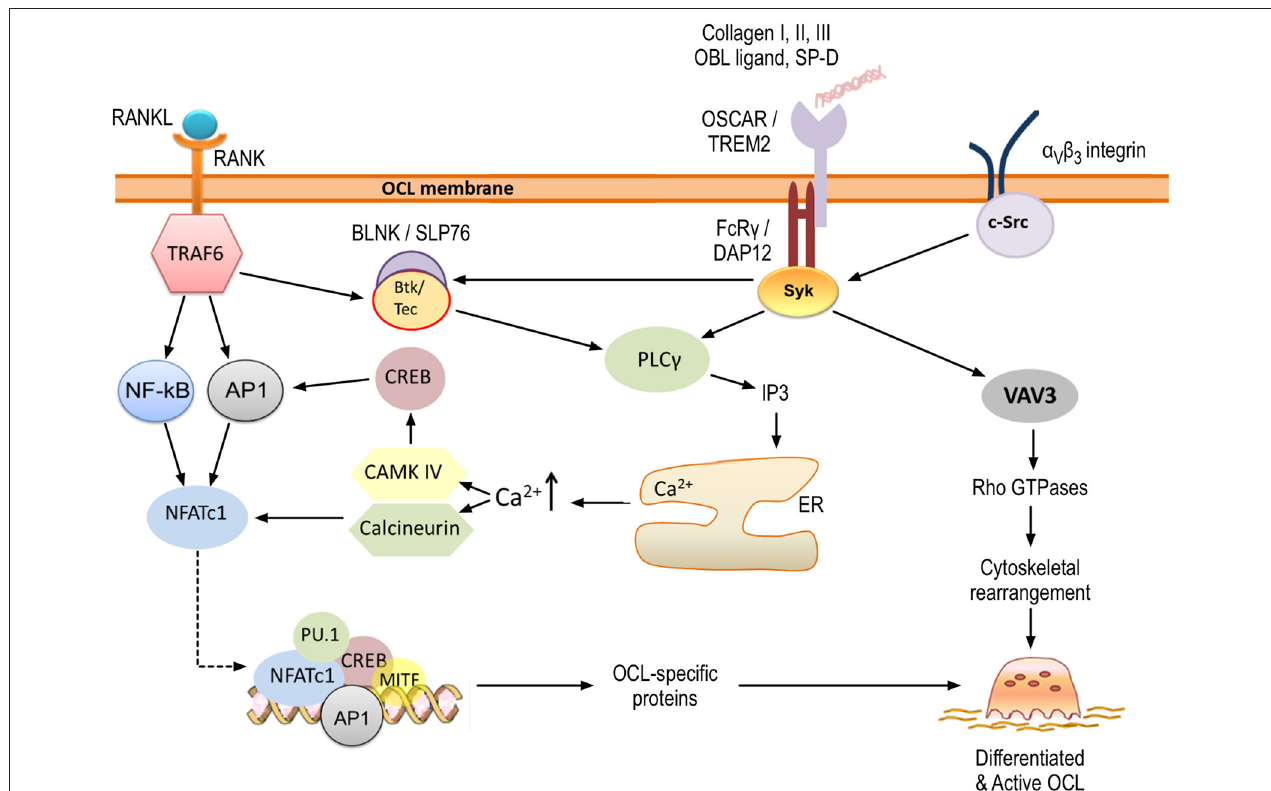
FIGURE 4 | OSCAR signaling in osteoclastogenesis. OSCAR associates with FcR γ and provides co-stimulatory signals for osteoclast maturation and activation. RANK-RANKL interaction leads to initial induction of NFATc1, which is amplified through OSCAR/FcR γ -mediated activation of CAMK IV and calcineurin. Ultimately, this leads to expression of osteoclast-specific proteins. In addition, OSCAR-FcR γ , in association with α v β 3 integrin, provides signals for cytoskeletal reorganization and thus osteoclast activation. Key tyrosine residues within FcR γ are phosphorylated by members of the Src family, leading to the recruitment of Syk kinase. The latter stimulates the activity of downstream effectors such as phospholipase PLC γ and guanine exchange factor VAV3, which subsequently activate further targets as shown. Details are provided within the body of the